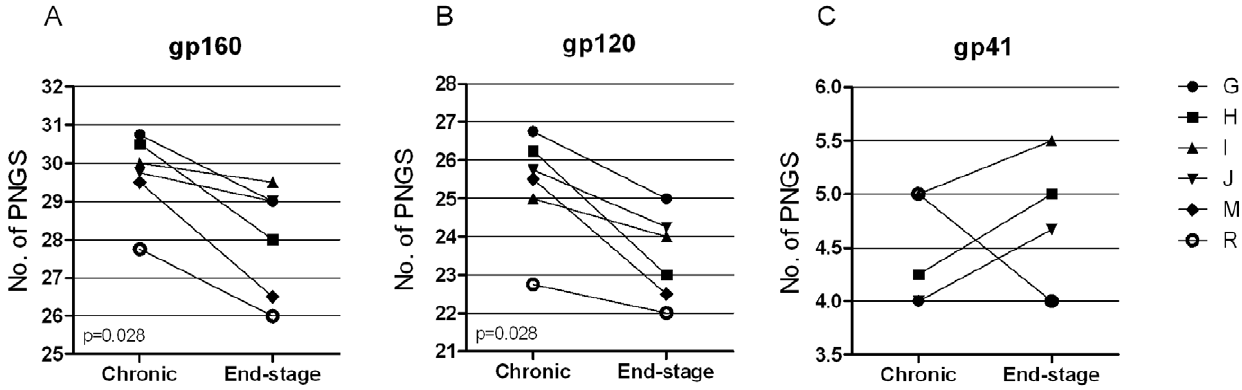
Figure 3. Evolution of PNGS modifications in HIV-1 R5 Env during end-stage disease progression. Differences in numbers of PNGS within a) gp160, b) gp120 and c) gp41 comparing the average PNGS numbers of four R5 sequences per isolate obtained longitudinally at the asymptomatic chronic phase and after AIDS onset at end-stage disease.